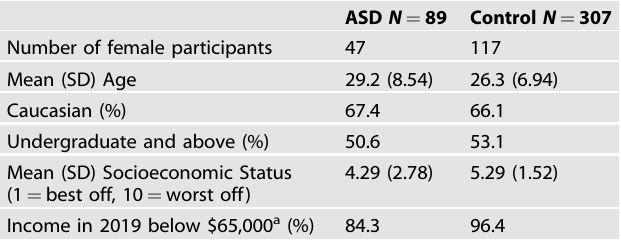
Table 1. Demographics of the ASD and the control